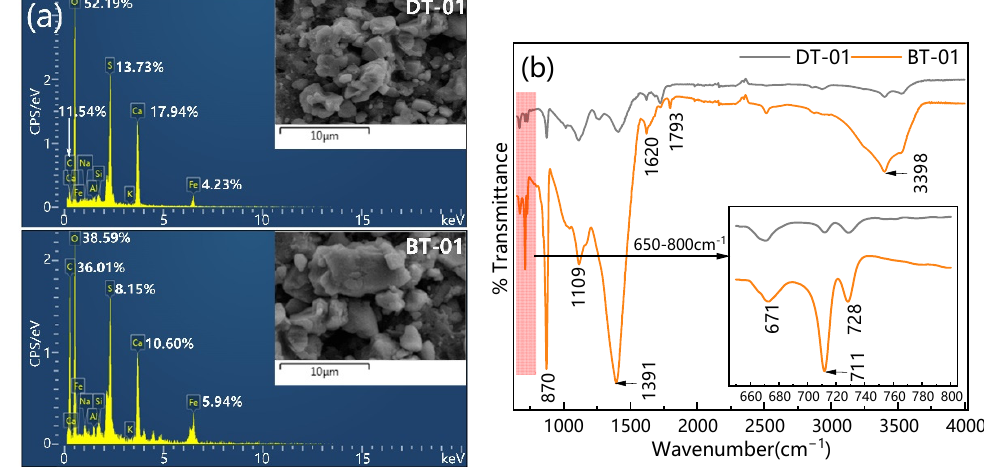
Figure 4. ( a ) Elemental analysis by SEM-EDS and ( b ) Infrared spectra by FTIR spectroscopy for the red samples (DT-01 and BT-01).